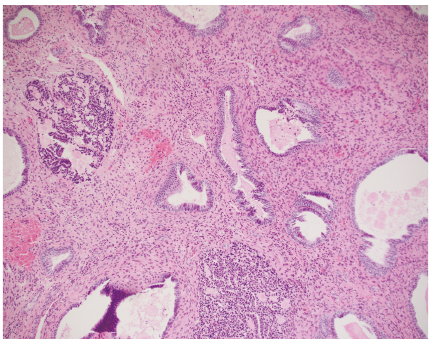
Figure 3: Microscopic section of polyp from case #1. H&E stain, demonstrating inactive endometrium, few glands, fibrotic stroma, and dilated, thick-walled blood